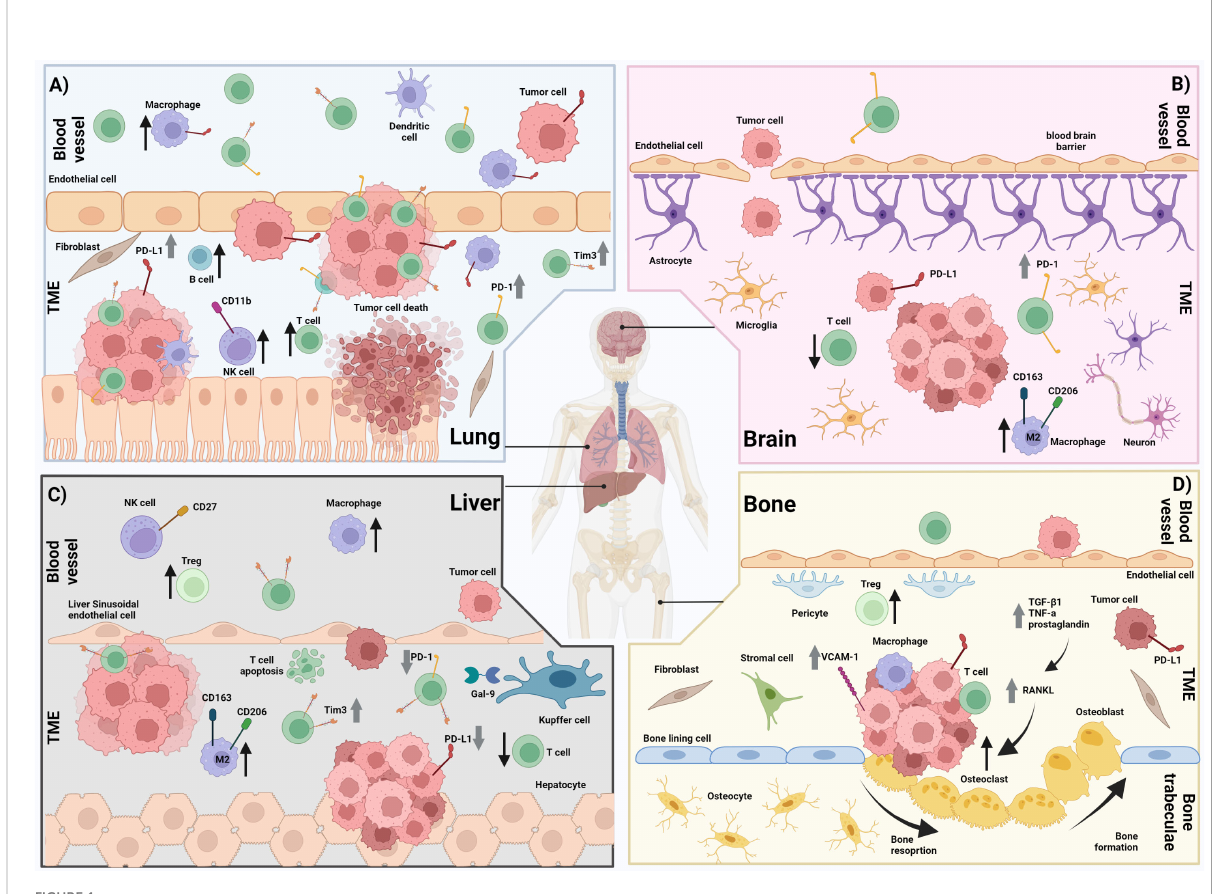
FIGURE 1 The immune microenvironment in lung, brain, liver and bone metastases. (A) Lung metastasis showing a higher in fi ltration of T cells, macrophages, dendritic cells, B cells, fi broblasts and CD11b+ NK cells compared with other sites of metastases (e.g. liver, brain, and bone). There is increased T cell expression of PD-1 and increased tumor and macrophage expression of PD-L1 compared with other sites of metastases (e.g. liver, and brain). B) Brain metastasis showing a higher in fi ltration of M2 macrophages and reduced in fi ltration of T cells compared with other metastases (e.g. lung). There is also increased T cell expression of PD-1 compared with other metastases (e.g. liver) and a disrupted blood brain barrier. (C) Liver metastasis showing reduced in fi ltration of T cells but increased in fi ltration of macrophages including M2 macrophages, and CD27+ NK cells compared with other metastases (e.g. lung and bone) There is also reduced T cell expression of PD-1 and high T cell expression of Tim-3 compared with other metastases (e.g. brain, lung, and bone). Increased T cell apoptosis has been observed. (D) Bone metastasis showing an increased in fi ltration of fi broblasts and stromal cells compared with other metastases (e.g. liver and brain). There is also increased tumor expression of PD-L1 and VCAM-1 compared with other metastases (e.g. liver and brain). An increase in the RANKL pathway leading to increased osteoclasts and subsequently increased osteoclast driven bone resorption is also observed in bone metastases. ↑ = Increased cell in fi ltration ↓ = Decreased cell in fi ltration ⇧ = Increased expression ⇩ = Decreased expression TME = Tumor microenvironment. Created with